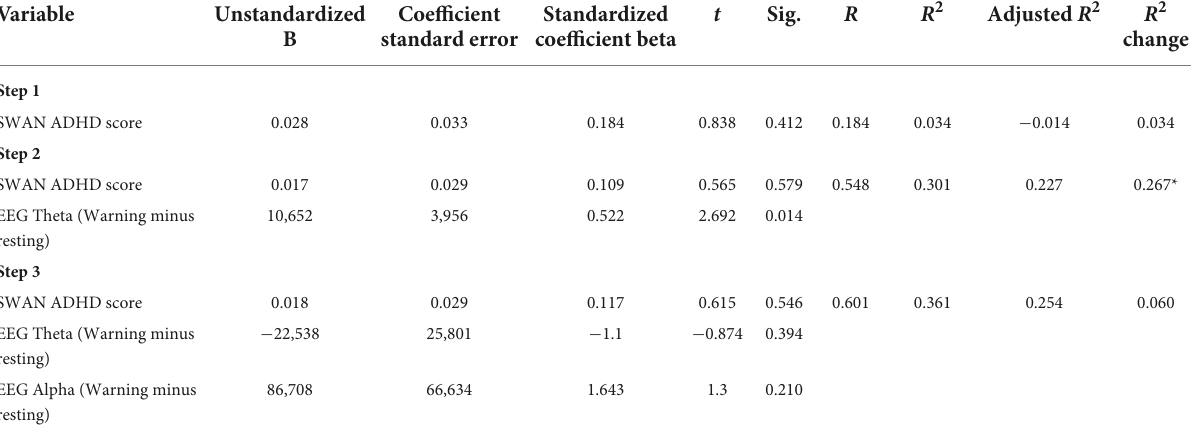
TABLE 3 Regression model of the EEG measures as the predictors of the CCPT omissions in the SCT group.